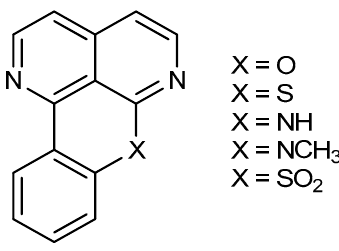
Figure 11. Sampangine derivates by modification of the C7 group [161].